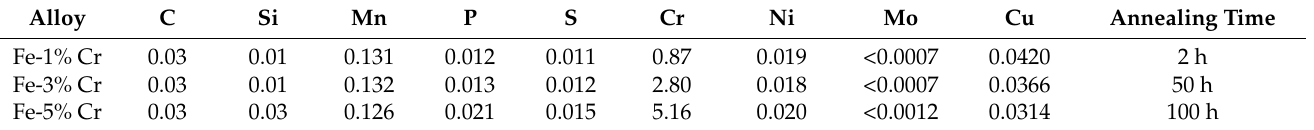
Table 1. Chemical composition (in wt%) of binary Fe-Cr alloys and time of annealing.